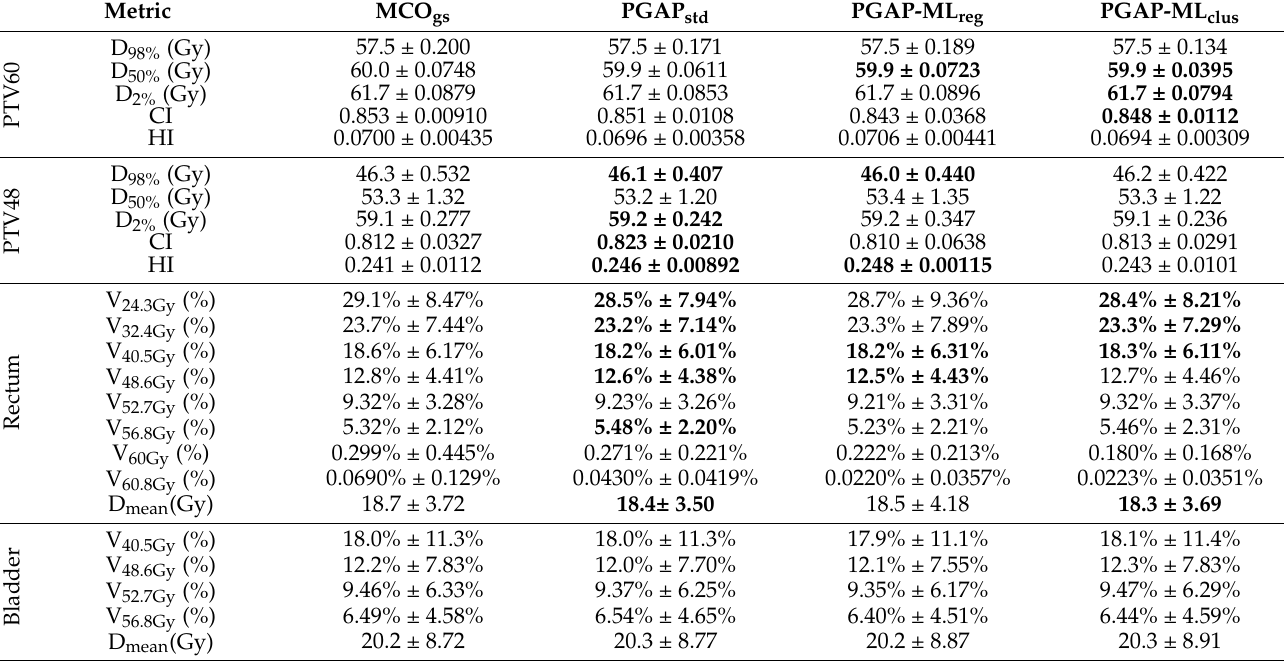
Table 9. Summary of key dose metrics. Values shown are mean ± 1 standard deviation. Statistical difference at the 95% level of significance is indicated by